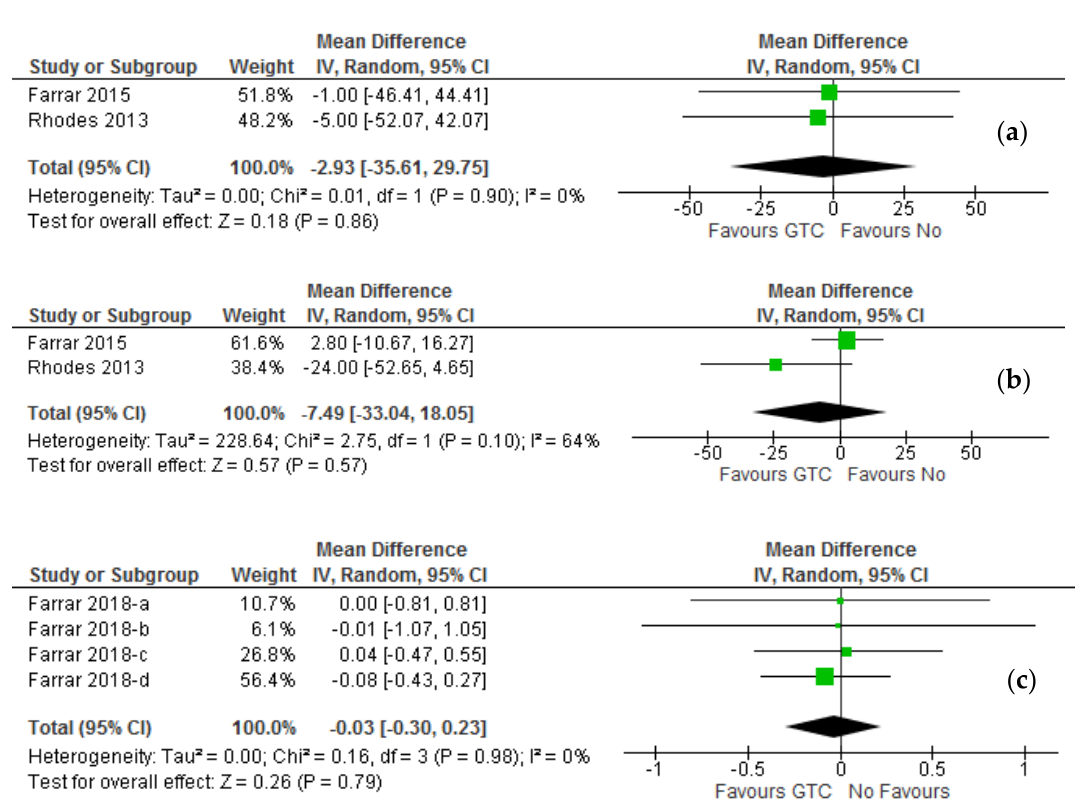
Figure 6. Forest plot of randomized controlled studies in healthy adults comparing the effect of before (pre − ) and after (post-) oral green tea catechin interventions at the varying intensity of MED challenge showed a nonsignificant inhibition of ultraviolet radiation-induced pro-inflammatory mediators. ( a ) PGE 2 ; ( b ) 12-HETE, and ( c ) CPDs. Keys: As illustrated in Figure 3. The effect of studies is presented mean differences (MDs) at 95% confidence intervals (CIs) using the generic inverse variance (IV) random- effects model.